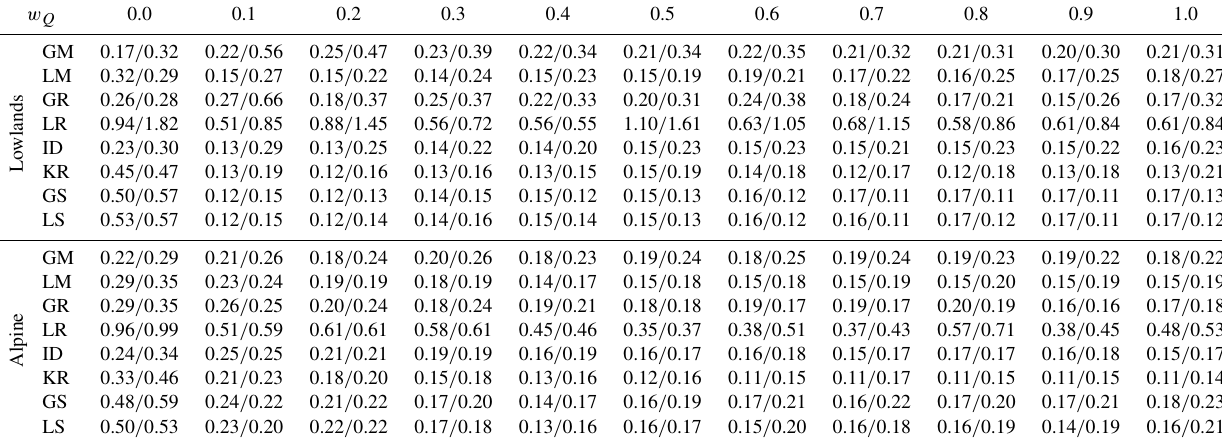
Table 3. Scatter (difference of 75% and 25% quantiles in model efficiency) of the leave-one-out runoff model efficiency (Eq. 5) obtained by eight groups of parameter transfer methods and 11 calibration weights for lowland (94) and alpine (119) catchments in the calibration (2000–2010; first value) and validation (2010–2014; second value) periods.